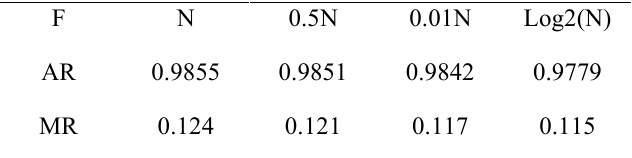
Table 2. The effect of F on performance of BL-KELM